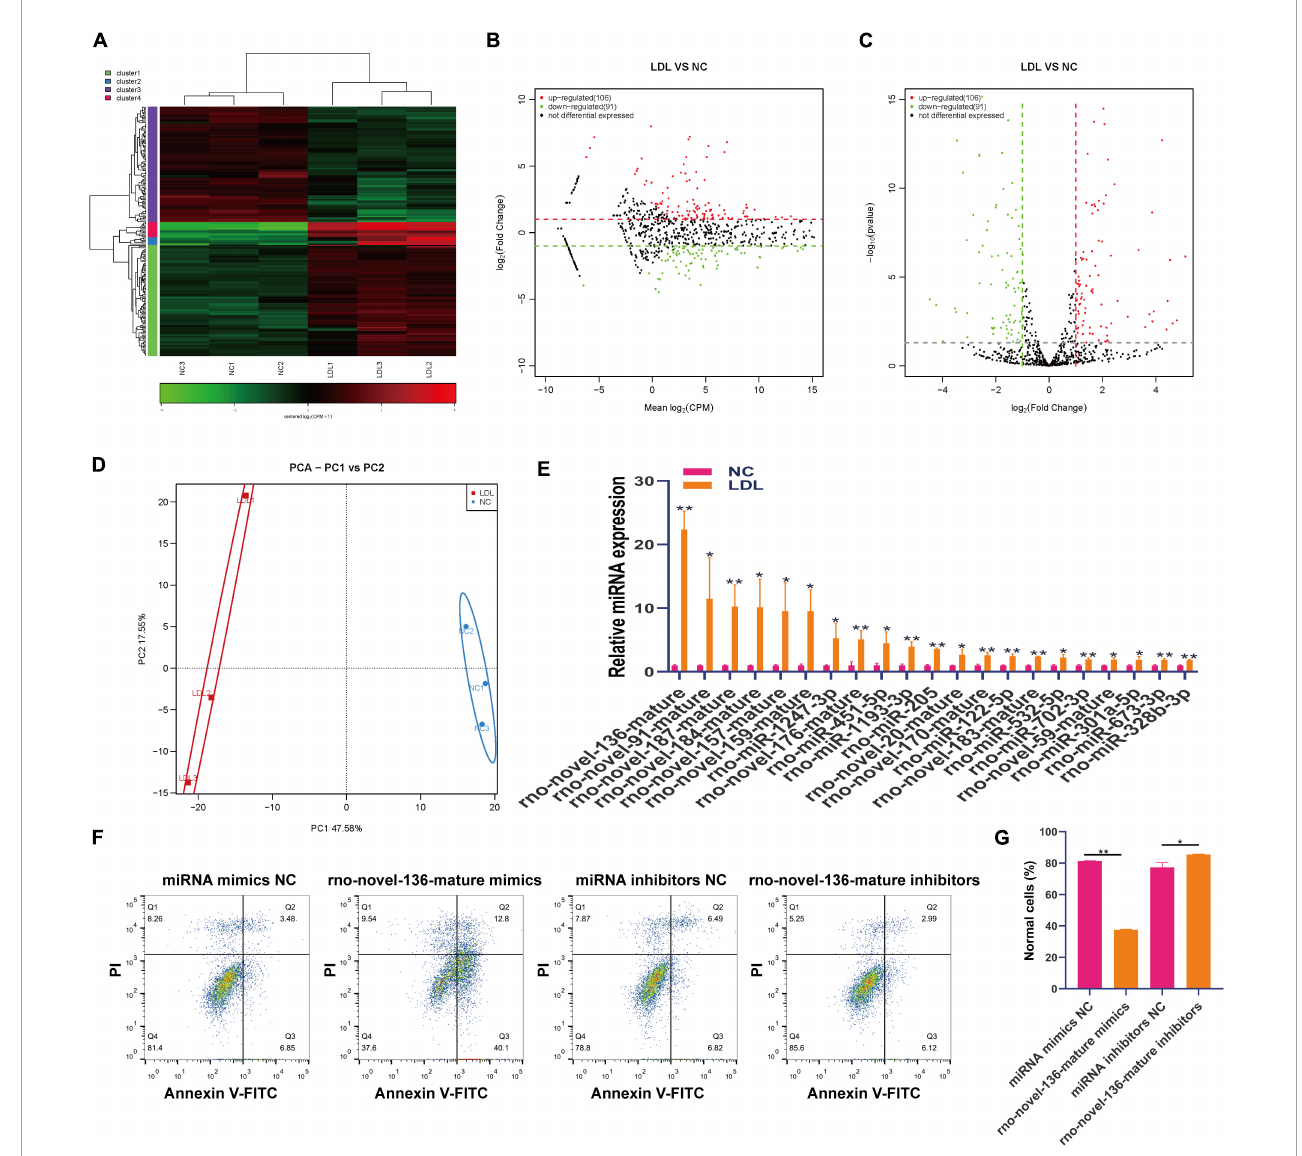
FIGURE4 Differential expression of miRNA in rat endothelial cells treated with ox-LDL. Heatmap (A) , MA map (B) , and volcano map (C) show the expression of miRNA in rat endothelial cells with ox-LDL treatment, n = 3. (D) PCA showed the expression of miRNA in rat endothelial cells with or without ox-LDL treatment, n = 3. (E) qPCR detected the expression of miRNA in rat endothelial cells with or without ox-LDL treatment. (F) Flow cytometry assay of cell apoptosis after treatment with rno-novel-136-mature mimic and rno-novel-136-mature mimic inhibitors. (G) Quantification of normal cells according to flow cytometric analysis. For the statistical analysis, three independent experiments were conducted. * p < 0.05, ** p <